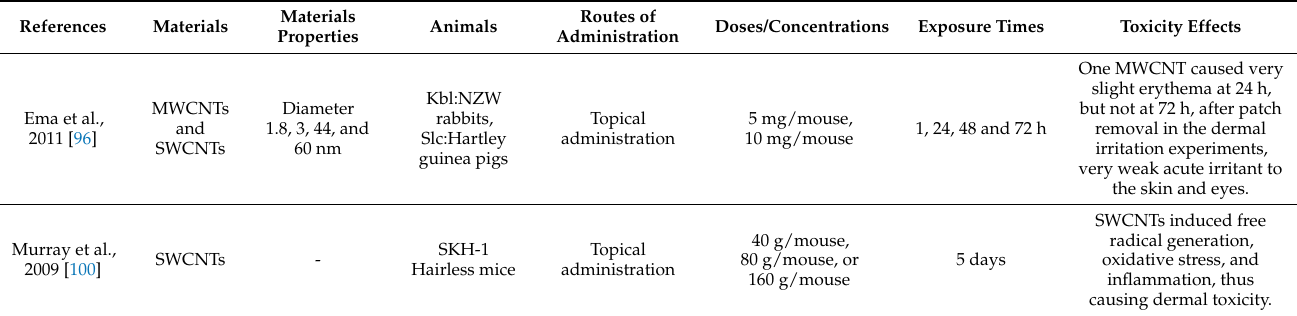
Table 4. Dermal toxicity of pristine carbon nanotubes using rodents as animal